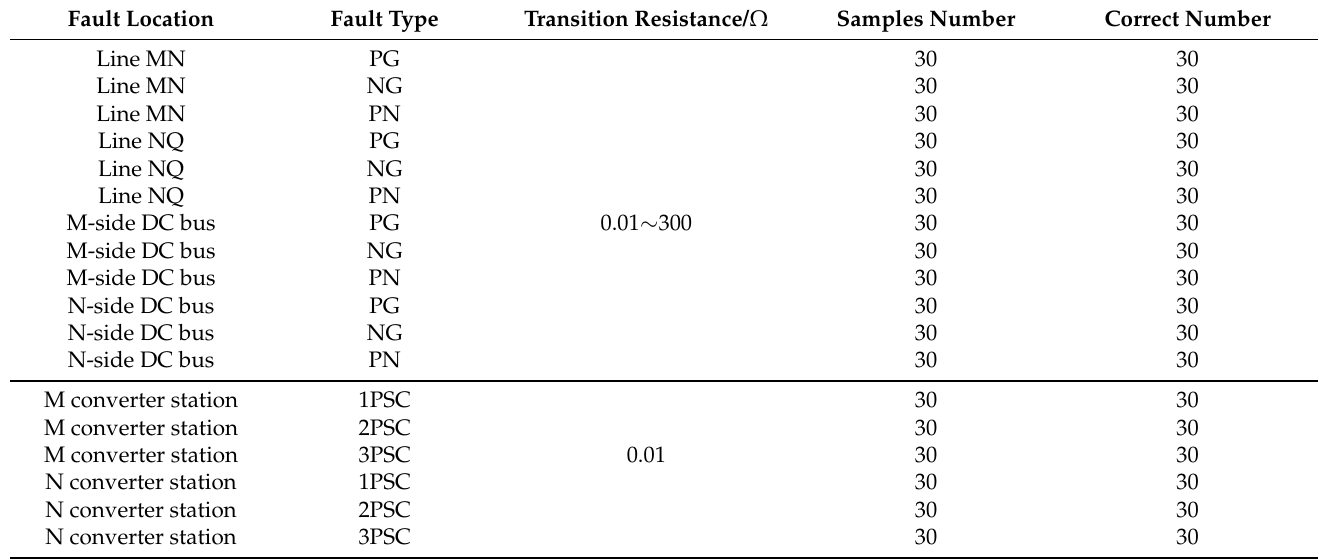
Table 6. Test results of noise